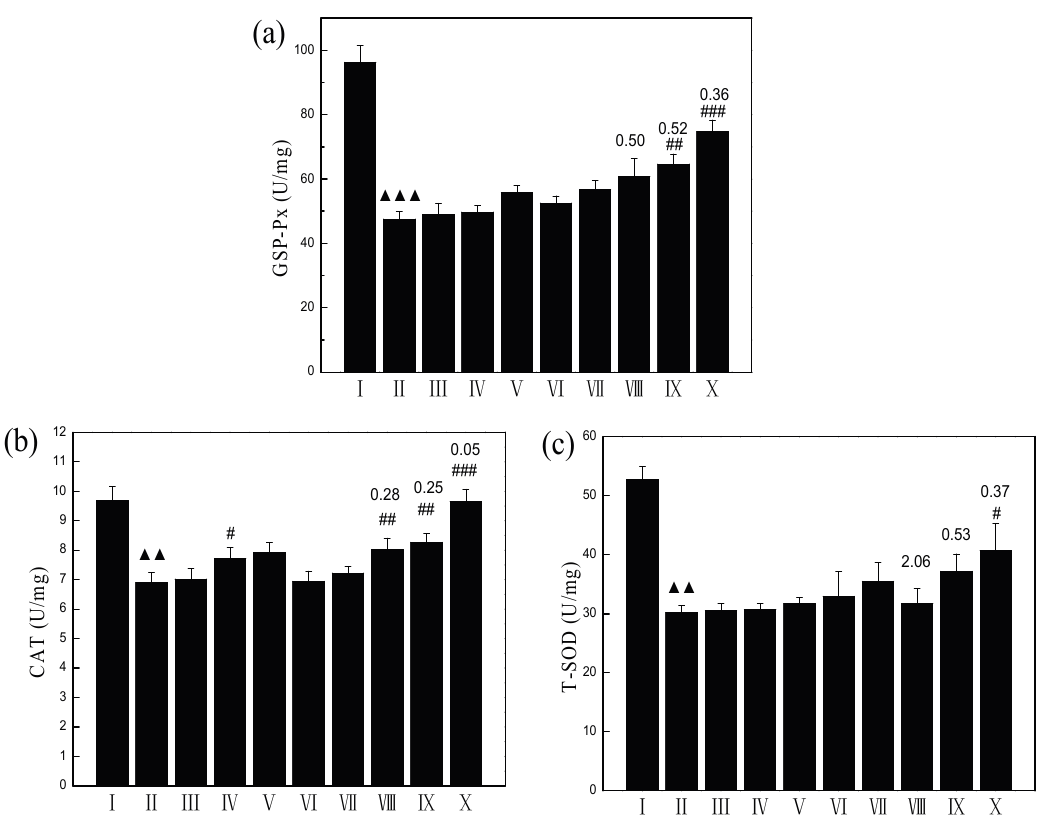
Figure 7. ( a ) Effect of GSP, AAP IV, and their combination on GSH-Px activity of splenocytes; ( b ) Effect of GSP, AAP IV, and their combination on CAT activity of splenocytes; ( c ) Effect of GSP, AAP IV, and their combination on T-SOD activity of splenocytes. ▲▲ p < 0.01, ▲▲▲ p < 0.005 compared with normal control group; # p <